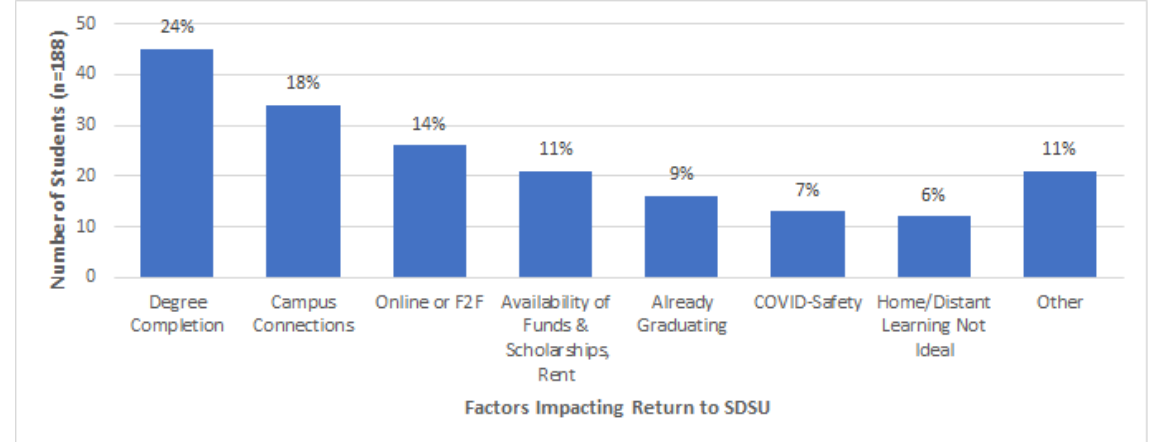
Figure 3: Factors affecting student decision to return to